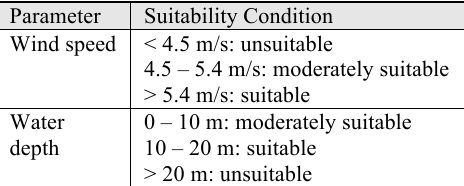
Table 2: Criteria used to rank non-excluded areas